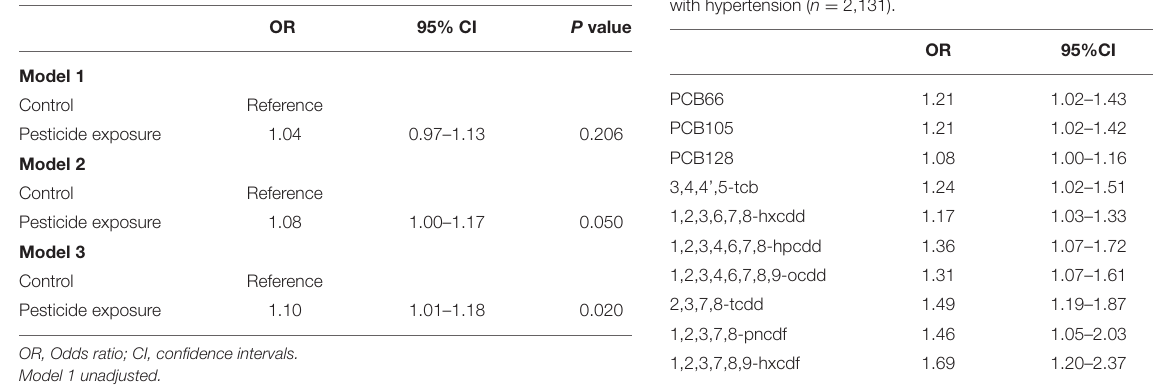
TABLE 2 | Associations between household pesticide exposure and hypertension.